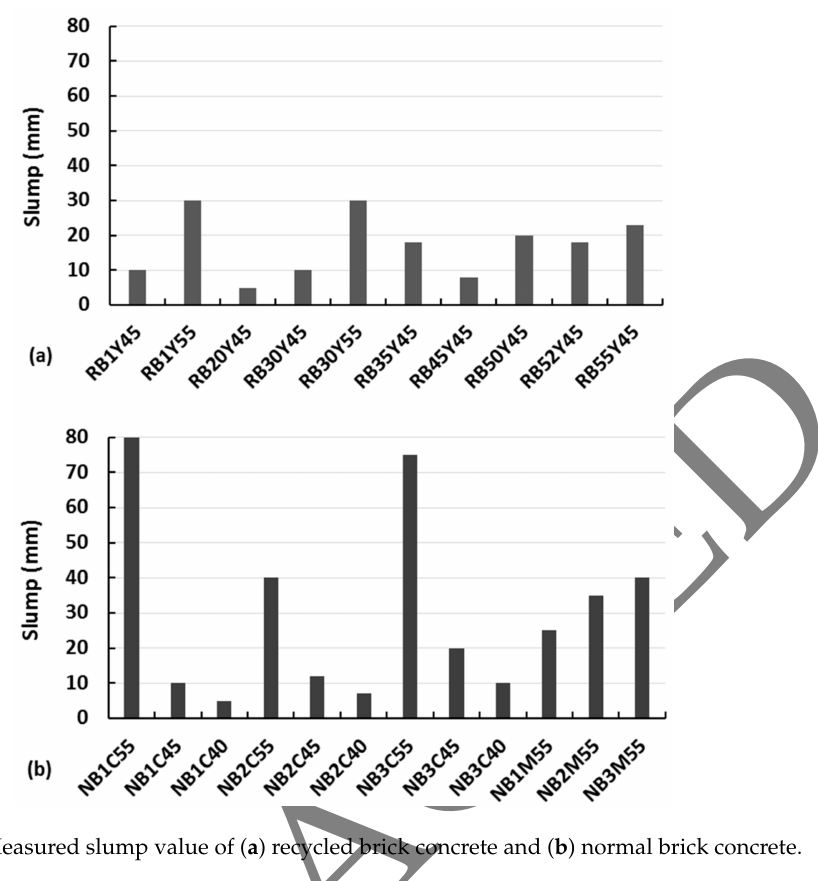
Figure 3. Measured slump value of ( a ) recycled brick concrete and ( b ) normal brick concrete.